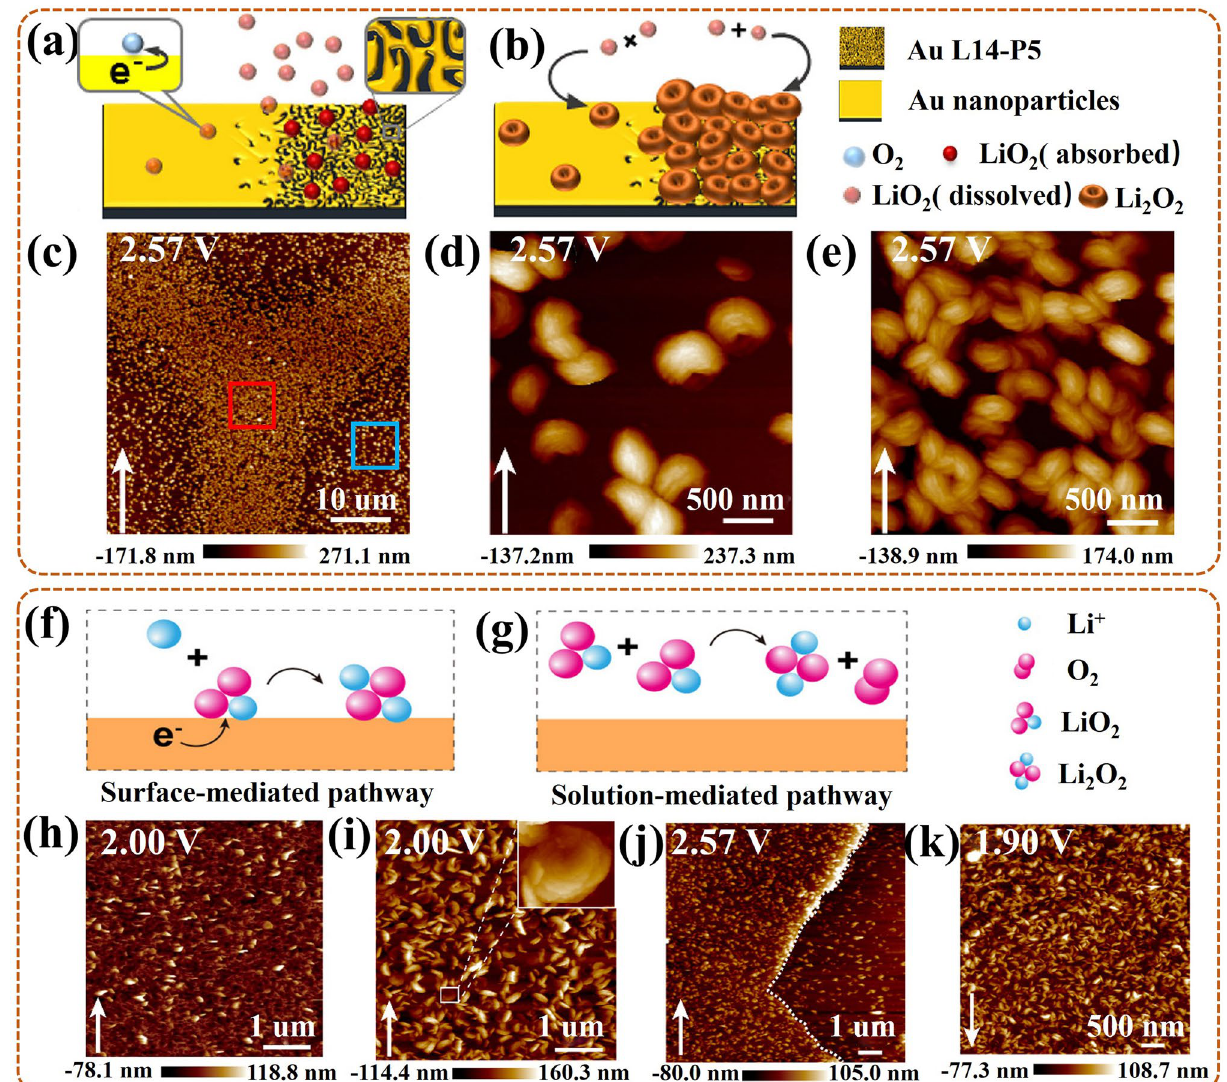
Fig. 12 Schematic of ORR processes on the Au NPs/Au L14-P5 electrode, a at early stage, b at end stage; In-situ AFM images of the composite electrode, c with the large-scale Li 2 O 2 deposition, d the ring Li 2 O 2 on Au NPs region (the enlarged blue frame of c ), e the ring Li 2 O 2 on Au L14- P5 region (the enlarged red frame of c ), with white arrow as scanning direction [97]; Reused with approval; Copyright 2020 American Chemical Society. Schematic of ORR processes reaction paths on, f Pt-0 electrode, g Pt-80 electrode; In-situ AFM images of h Pt-0 electrode, i Pt-80 elec- trode, j Pt-250 electrode, k Pt/Au NPs electrode, with white arrow as scanning direction [98]. Reused with approval; Copyright 2021 American Chemical Society. (Color figure